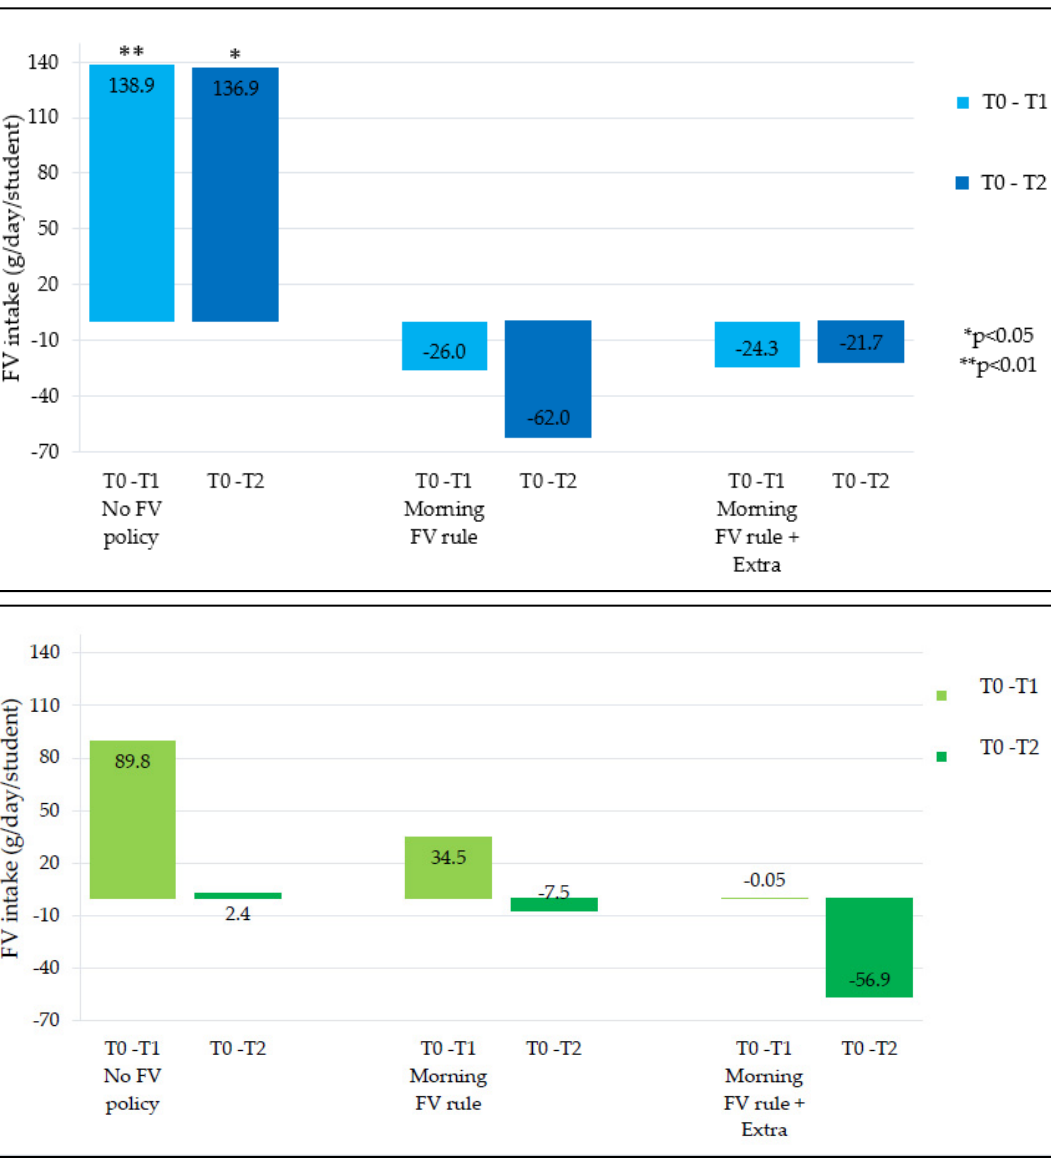
Figure 2. Difference in children’s FV intake stratified by school food policy in FV group, compared to control group; Difference in children’s FV intake stratified by school food policy in FV + Ed group, compared to control group.